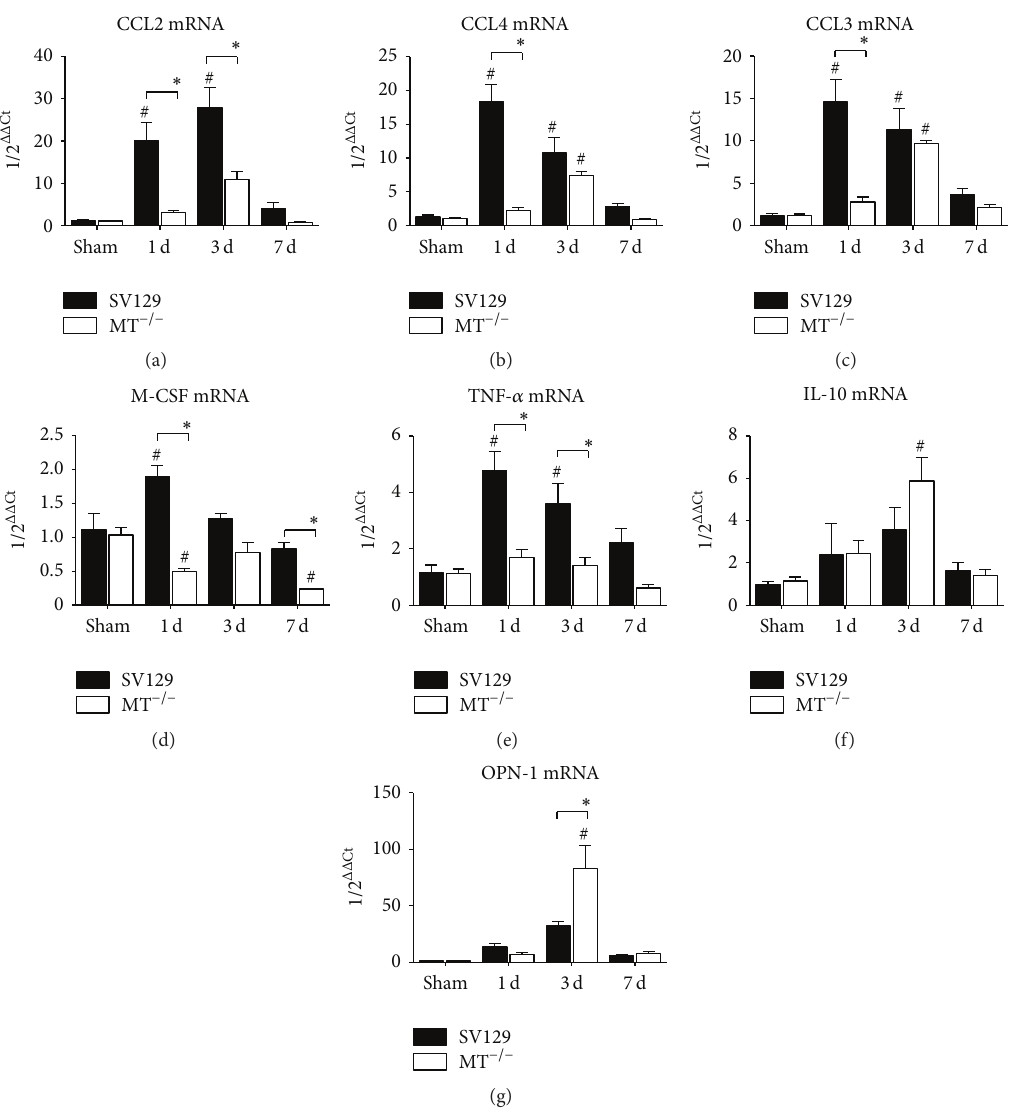
Figure 5: Gene expression of inflammatory mediators. Gene expression of macrophage-related chemokines (a) CCL2 and (b) CCL4 and (c) neutrophil-related CCL3 as well as cytokines (d) macrophage colony-stimulating factor (M-CSF), (e) TNF- 𝛼 , (f) IL-10, and (g) osteopontin (OPN)-1. 𝑛 = 8–10/group; RT-qPCR using Taqman, mRNA expression is related to shams and GAPDH using comparative ΔΔ Ct-method; ∗ indicates P ≤ 0.05 between the genotypes; # indicates P ≤ 0.05 versus respective